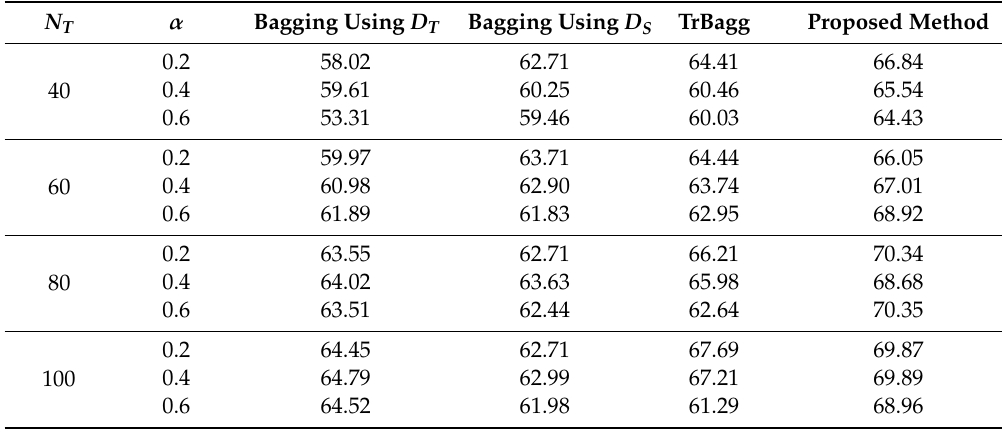
Table 4. Accuracy of test data using the wine quality